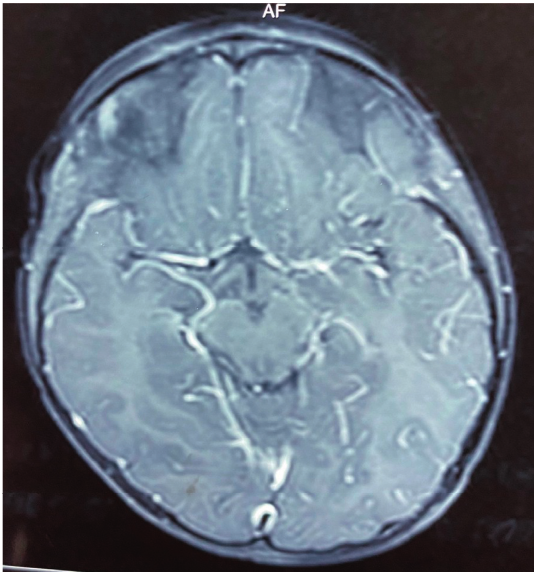
Figure 1: MRI brain during the acute stage showing high signal intensities in the midbrain at the site of single central levator subnucleus of the oculomotor nerve (arrow).